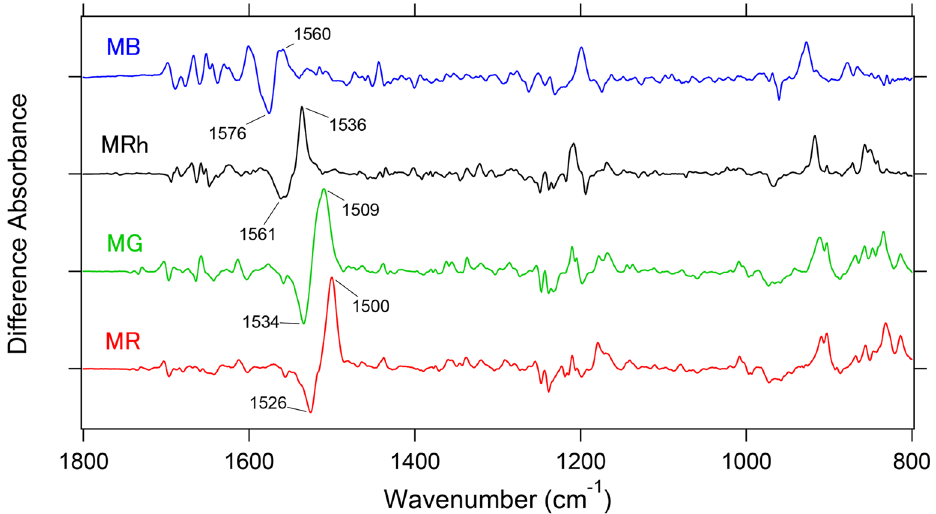
Figure 1. Light-induced difference FTIR spectra of MB, MRh, MG and MR in the 1800–800 cm − 1 region at 77 K. Light-induced all- trans minus 11- cis difference FTIR spectra of MB, MRh, MG and MR in the 1800–800 cm − 1 region measured at 77 K in D 2 O. The negative bands originate from the 11- cis form in the unphotolyzed state, whereas the positive bands originate from the all- trans form (batho-intermediate; Batho) after retinal photoisomerization. One division of the y-axis corresponds to 0.0015 absorbance units. A pair of bands at 1600–1500 cm − 1 for each pigment corresponds to the ethylenic C = C stretching vibration of the retinal chromophore, and their spectral down-shifts correspond to the red-shift in the visible